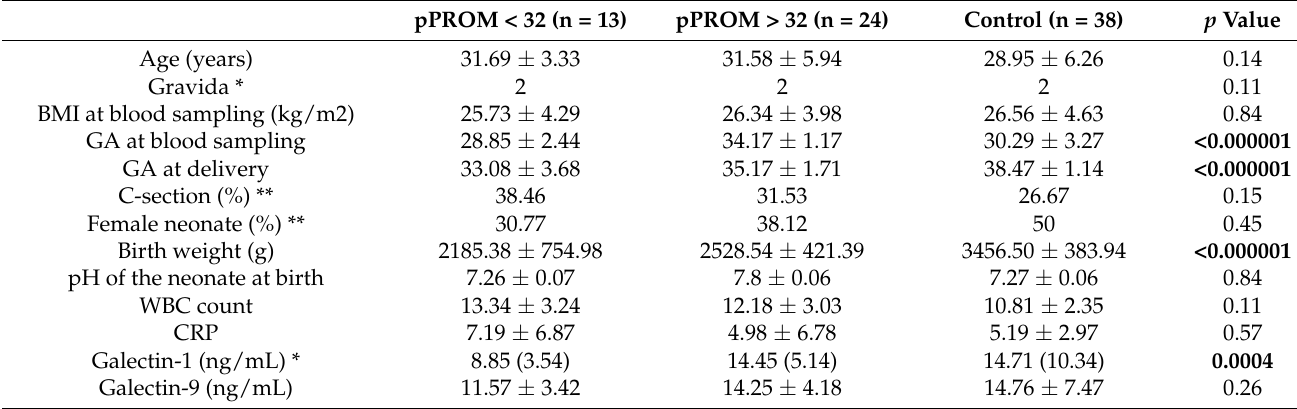
Table 2. Demographic and clinical characteristics with distinction for early (<32 GW) and late (>32 GW) pPROM.